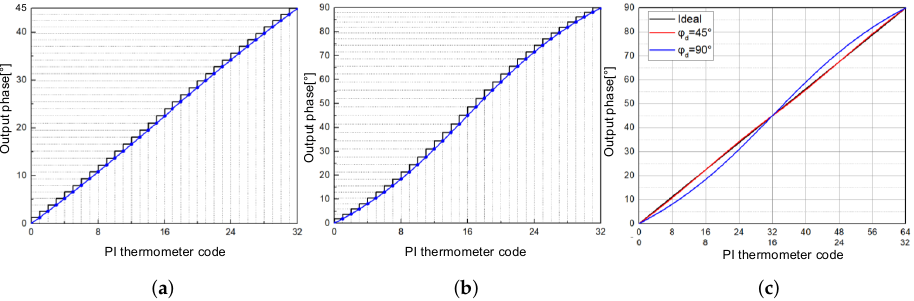
Figure 16. Linearity analysis and comparison of PI. ( a ) is the output phase with the thermometer code changing when ϕ d = 45 ◦ , ( b ) is the output phase with the thermometer code changing when ϕ d = 90 ◦ , ( c ) is the fitted curve of ( a , b ) and a ideal curve. (2)